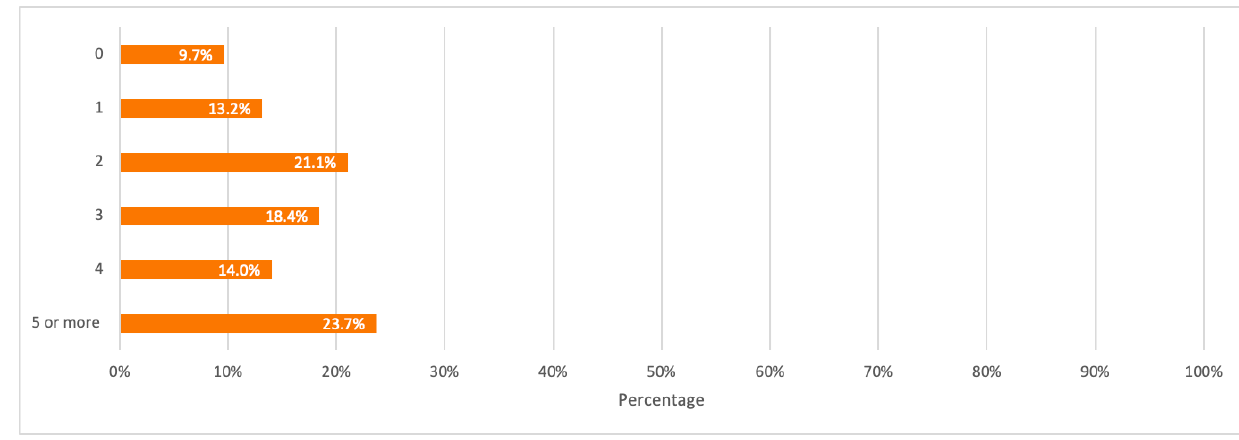
Figure 14. Number of mobile phones not in use and stored in households.